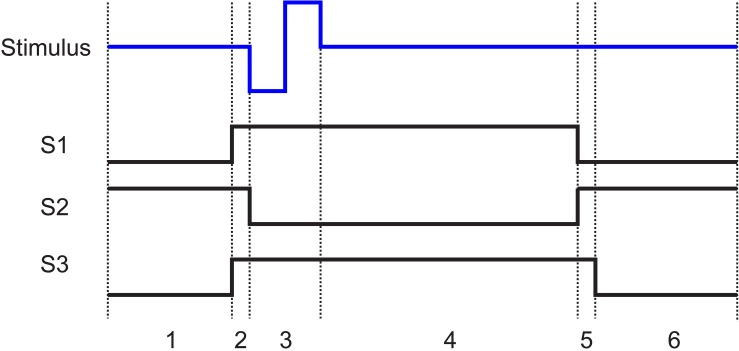
The state of the switches (1, closed; 0, open) shown in Figure 3a with respect to the stimulation pulse. In all cases when the stimulator is not pulsing, it is connected to ground. States 1 to 6 are as follows: 1. Recording: The electrode is connected to the recording amplifier while the stimulator and the resistor are disconnected. 2. Grounding: 200 μs before stimulation, the stimulator is connected to the electrode and the resistor is connected to the input of the amplifier. 3. Stimulation: The amplifier is disconnected from the electrode. The stimulation pulse is then applied to the electrode. 4. Discharge period: The electrode stays disconnected from the amplifier until the polarization voltage on the electrode falls below VT. 5. Discharge of residual charge (200 μs): The electrode is disconnected from the stimulator and connected to the recording system. The resistor remains connected to the input of the amplifier to absorb any charge injection due to residual offset on the electrode. 6. Recording resumed: The termination resistor is disconnected, and recording is resumed.